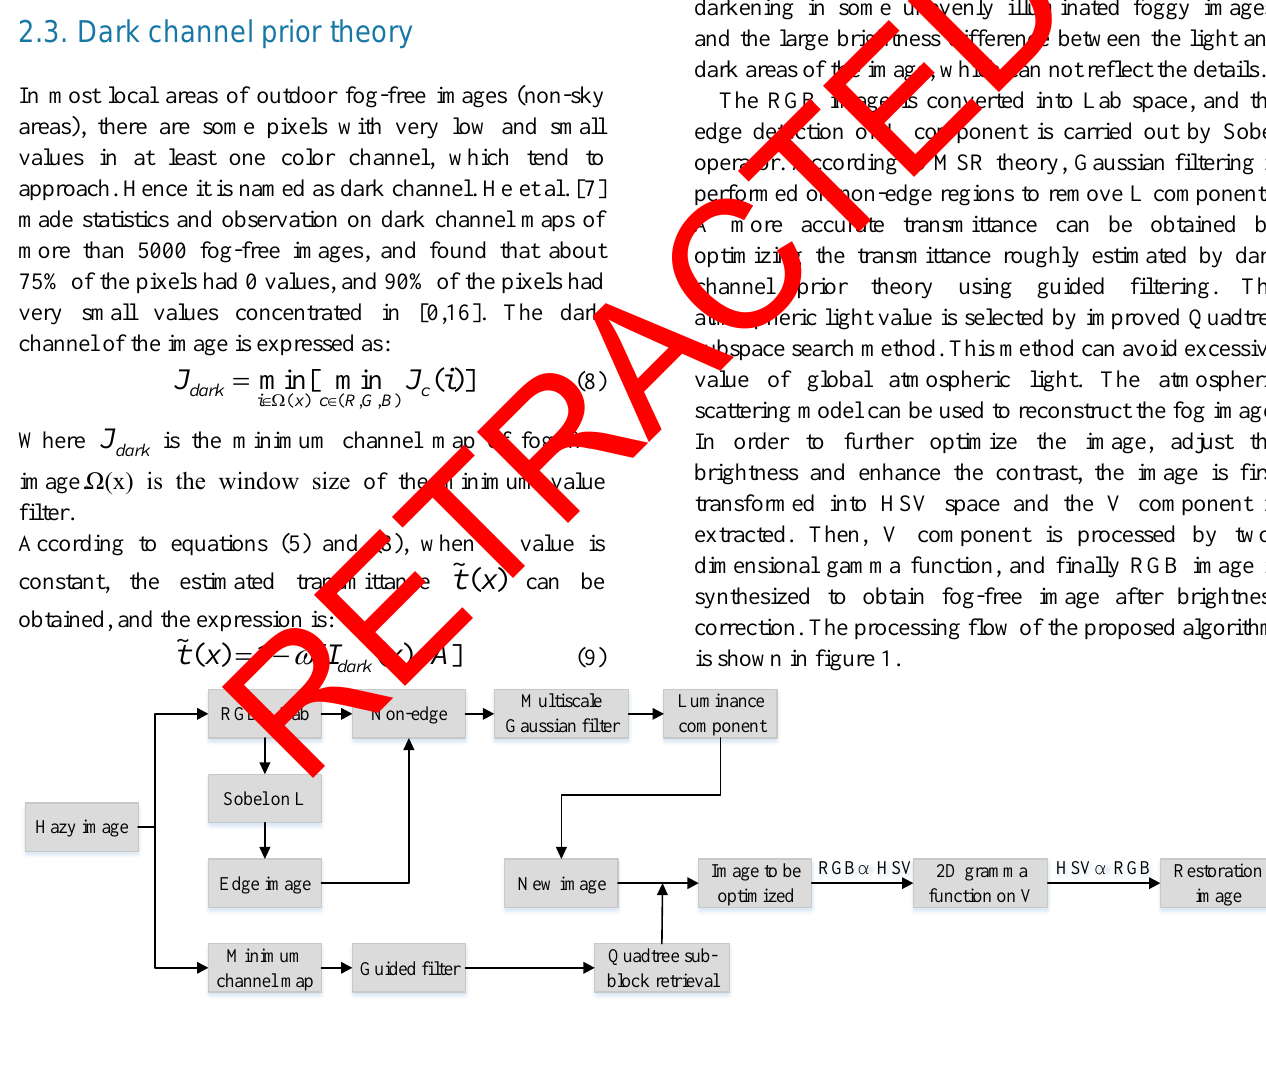
Figure 1. Flowchart of proposed